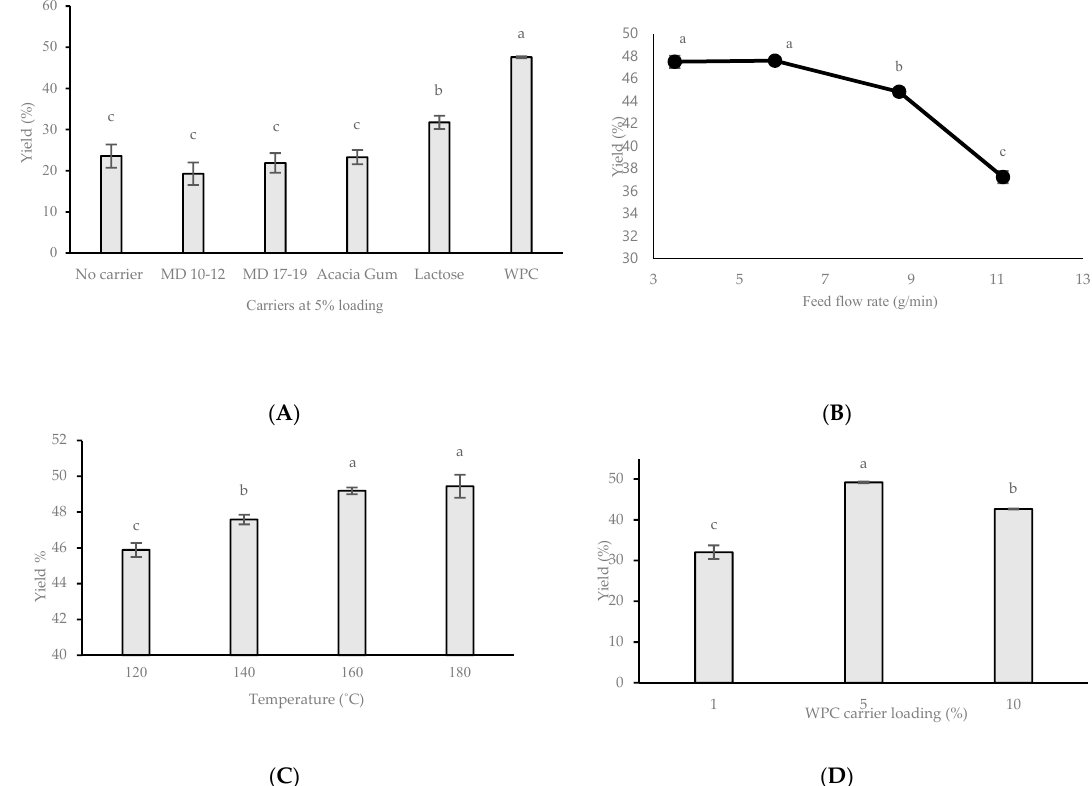
Figure 2. Yield of spray dried avocado wastewater (AWW) under different spray drying conditions. Each data point was measured in triplicate ( n = 3) where error bars represent standard deviation of means. ( A ) Effect of carrier types on powder yield when drying temperature of 140 °C, 5.8 g/min feed flow rate, and carrier concentration of 5% w/w with respect to AWW were kept constant; ( B ) Effect of feed flow rate on powder yield when drying temperature of 140 °C and 5% whey protein concentrate (WPC) carrier loading were kept constant; ( C ) Effect of spray drying temperature on powder yield when flow rate of 5.8 g/min and 5% WPC carrier loading were kept constant; ( D ) Effect of WPC carrier loading at a constant feed flow rate of 5.8 g/min and drying temperature of 160 °C. Superscript letters that are the same do not differ statistically based on Tukey’s test ( p < 0.05).